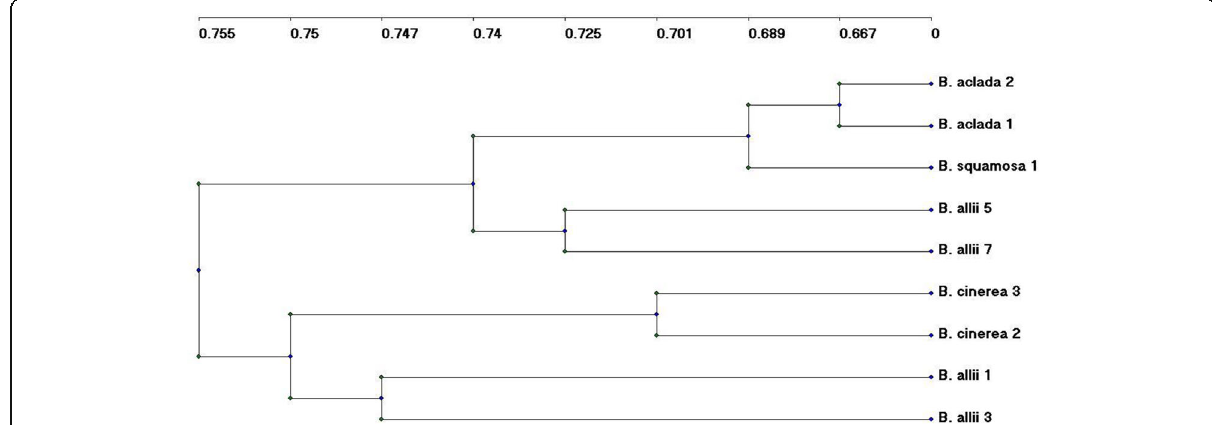
Fig. 3 Dendrogram developed from PCR-RAPD five primers using UPGMA analysis. The scale is based on Nei and Li coefficients of